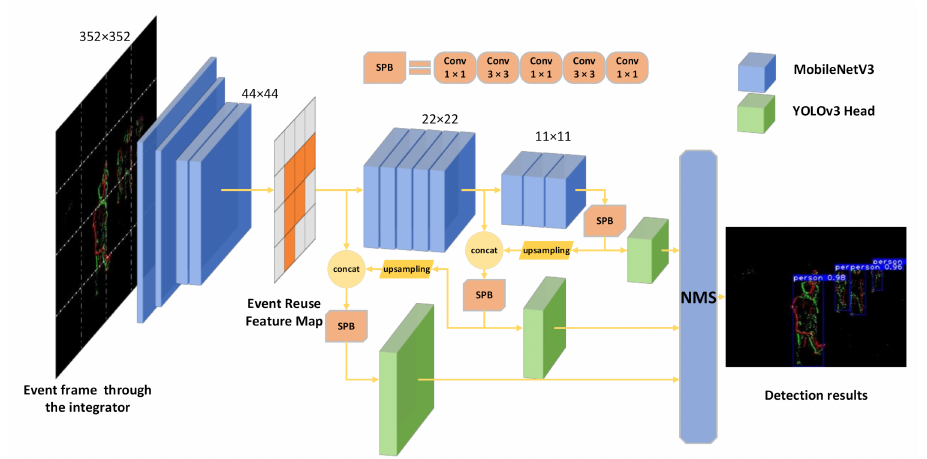
Figure 3. Framework of the pedestrian detector with grids partition of feature maps. The event-frame through the integrator is divided into 4 × 4 grids, and only the changed grids will be calculated by CNN to get the intermediate feature map, and then the corresponding area of the feature map saved in the previous frame is updated (6 orange marked grids). The fused intermediate feature map is used as the feature of the current frame and is inputted into the latter part of the detector. The detection result is acquired from all the three prediction branches through the NMS (Non-Maximum